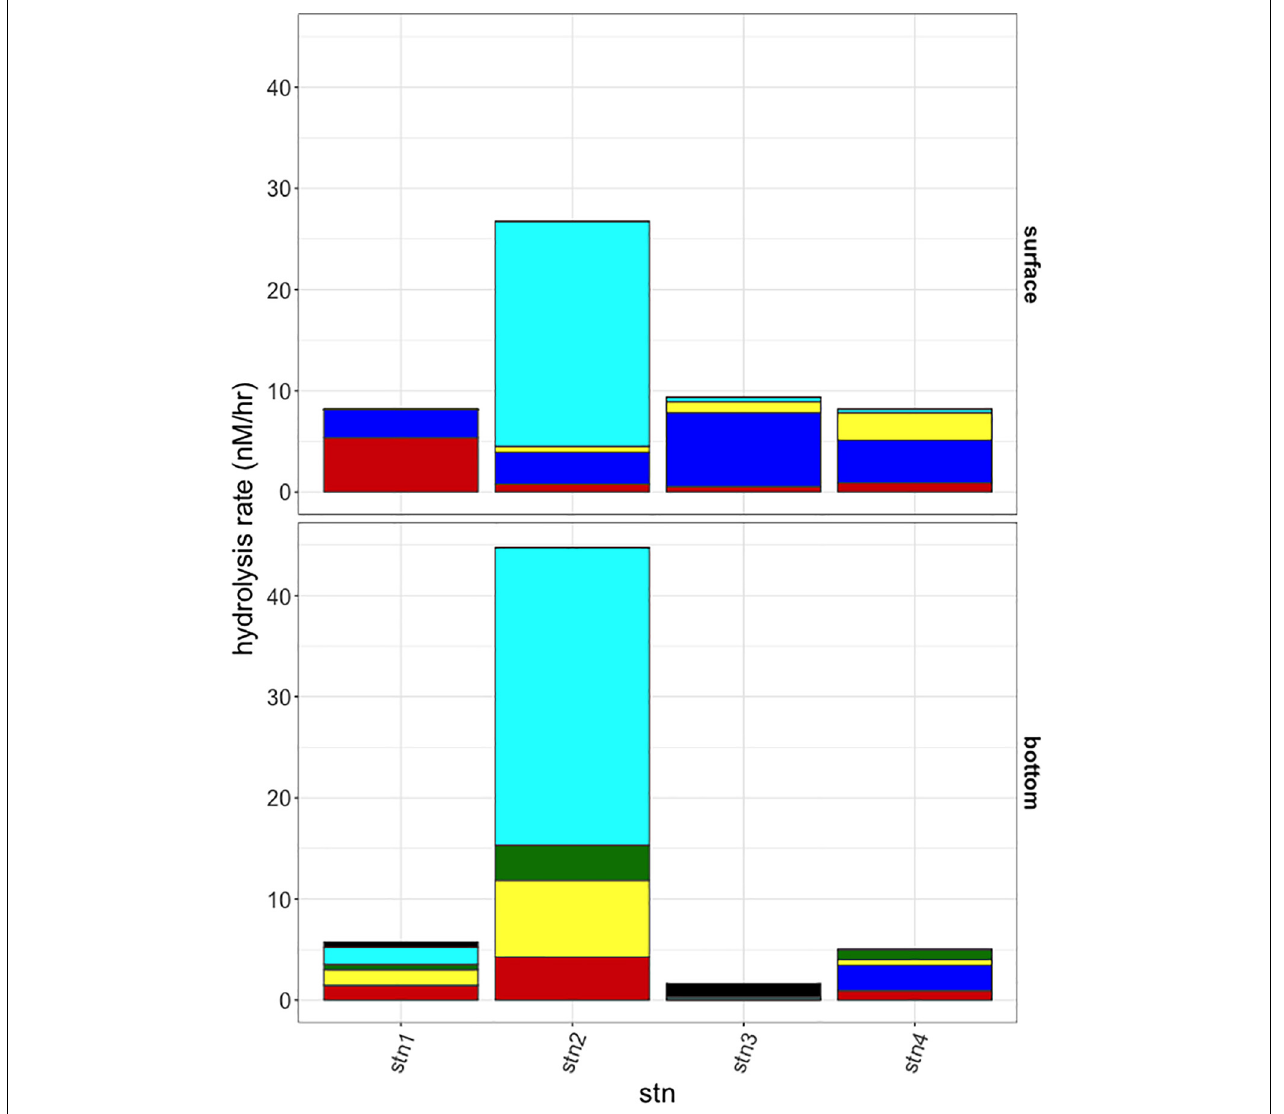
FIGURE 3 | Hydrolysis rates at the 48 h sampling timepoint for the six polysaccharide substrates at each station (left to right) and surface and bottom (top and bottom panels). Black: arabinogalactan; Turquoise: chondroitin sulfate; Green: fucoidan; Yellow: laminarin; Blue: pullulan; Red: